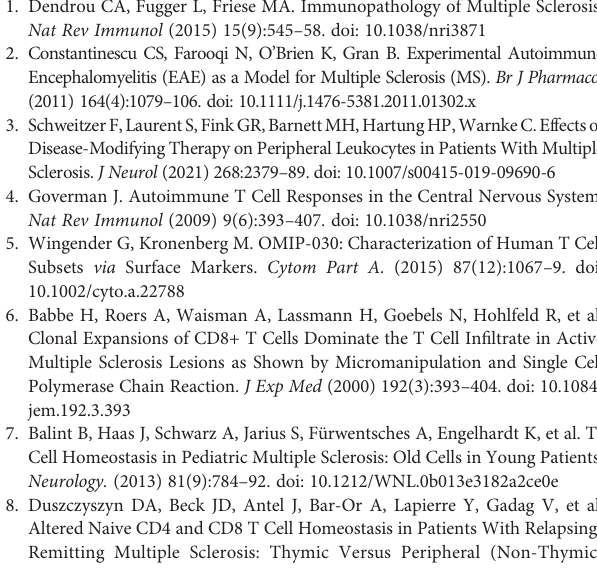
(CD45RA − HLA-DR − ) and the activated HLA-DR + (CD45RA − HLA-DR + ) Tregs (H)